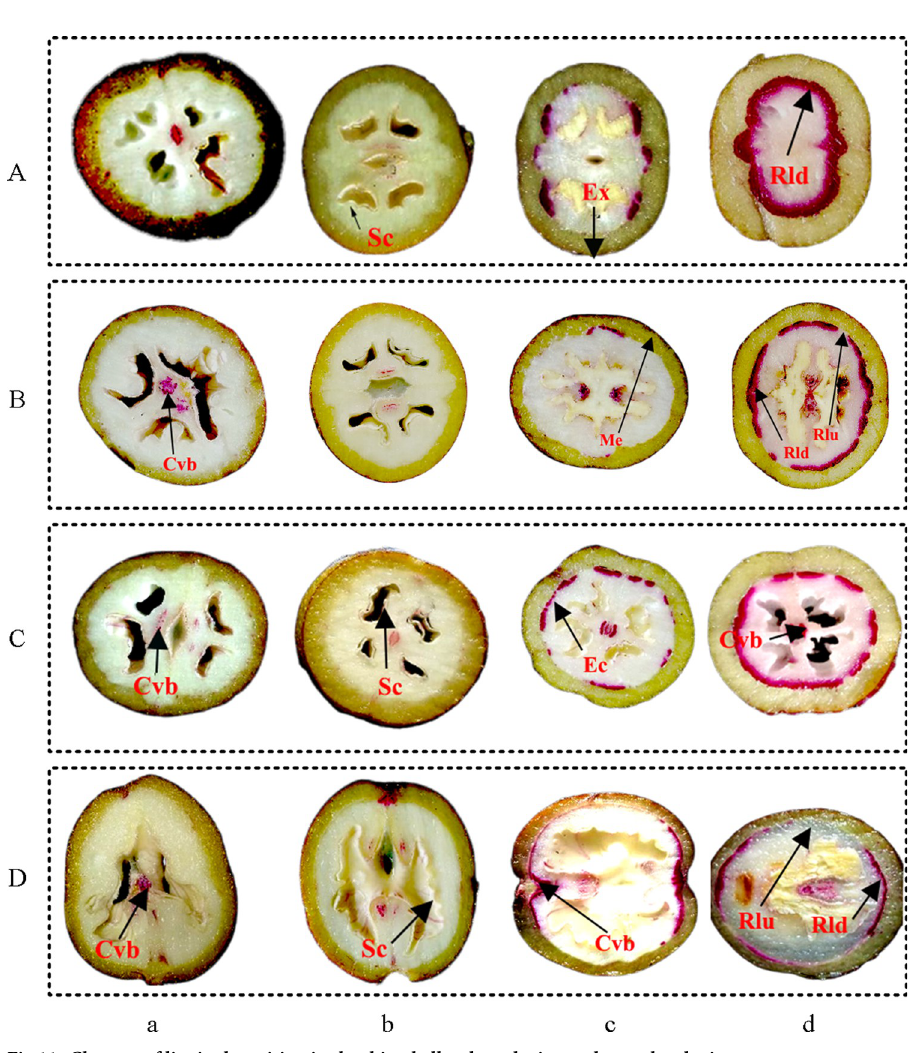
Fig 11. Changes of lignin deposition in the thin-shell walnut during endocarp